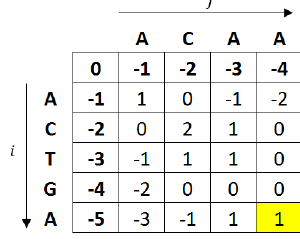
Figure 3. An illustration of how the Needleman-Wunsch algorithm can be computed using dynamic programming to align the sequences ‘ACTGA’ and ‘ACAA’. The score in each cell is computed using Equation (1), with match + 1, mismatch − 1, and a gap − 1.